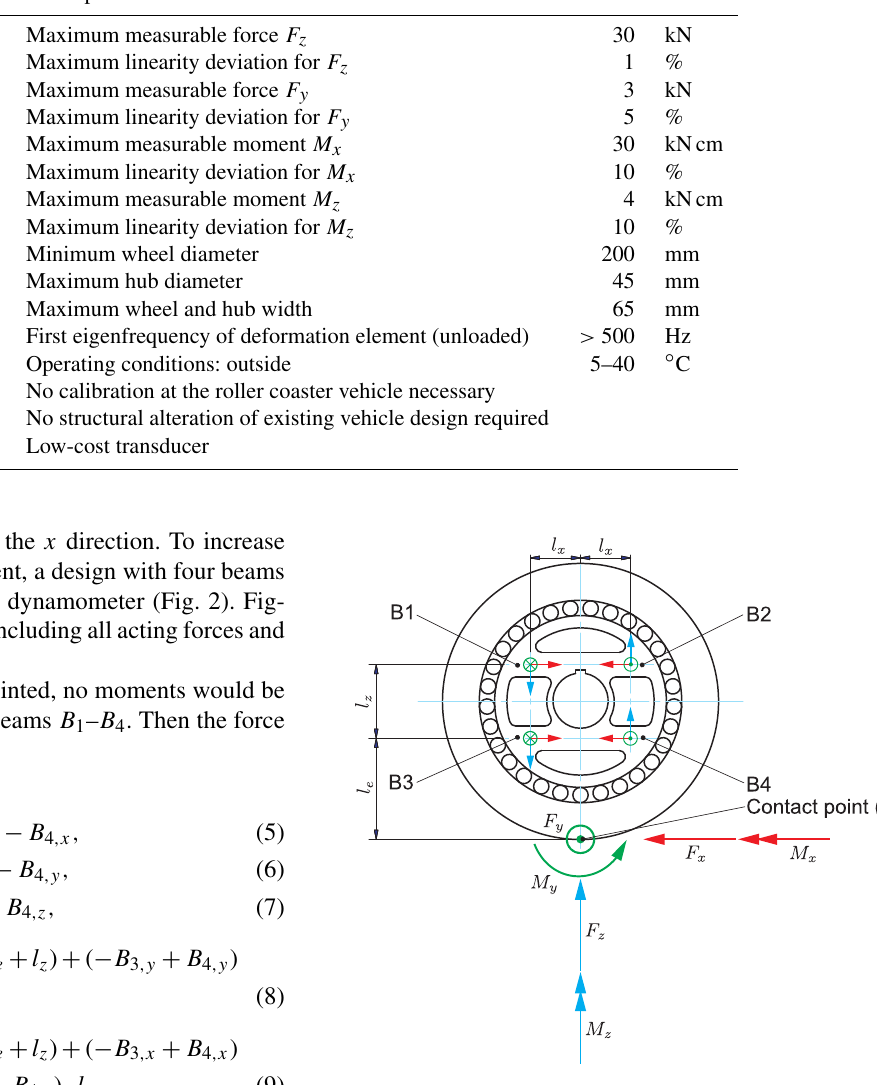
Figure 4. Scheme of the measurement